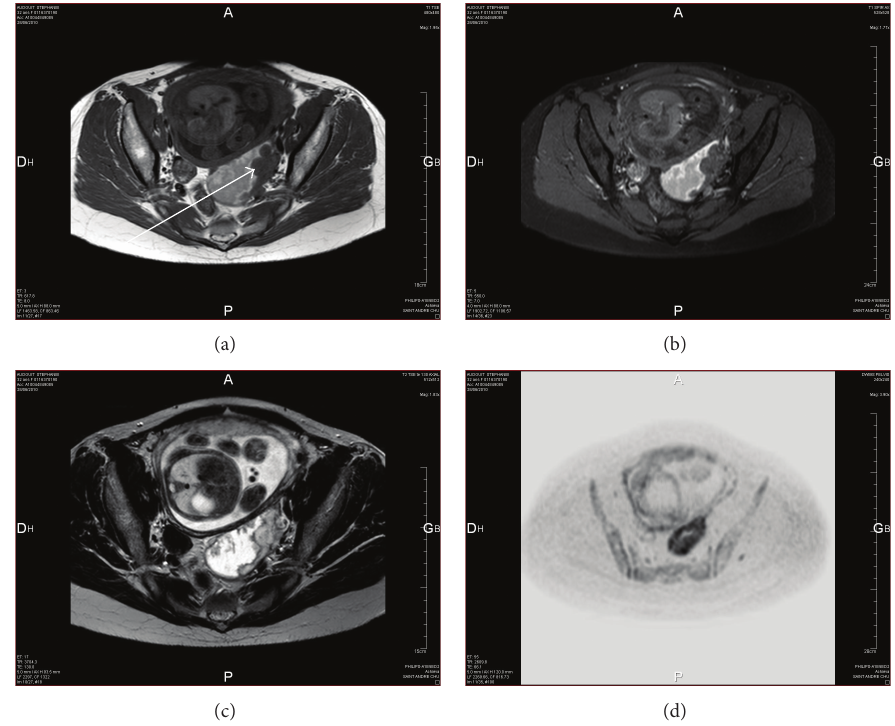
Figure 1: Magnetic Resonance Imaging features of the left decidualized ovarian mass. Axial T1 weighted image (a) demonstrates an intermediate signal intensity of the solid component in the left ovary (arrow), which remains unchanged on fat suppressed T1 weighted image (b). The solid component exhibits an intermediate T2 weighted signal (c) and a high diffusion-weighted signal